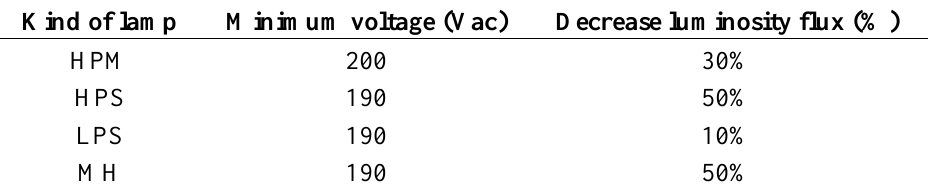
Table 13. Minimum voltage to decrease the light output